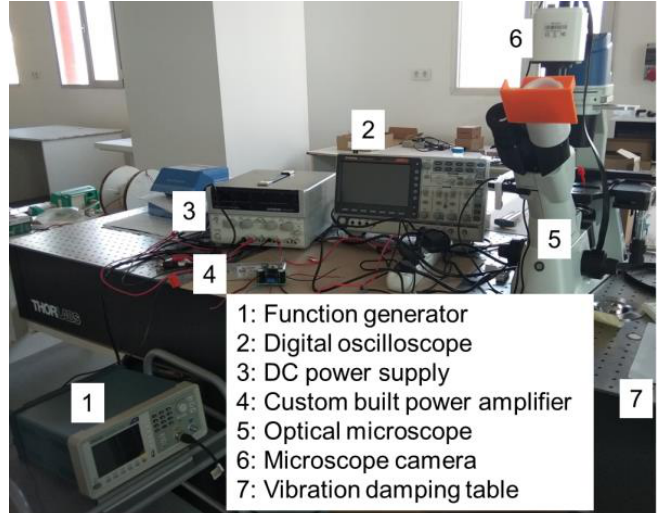
Figure 3. Experimental setup that is used for this study is